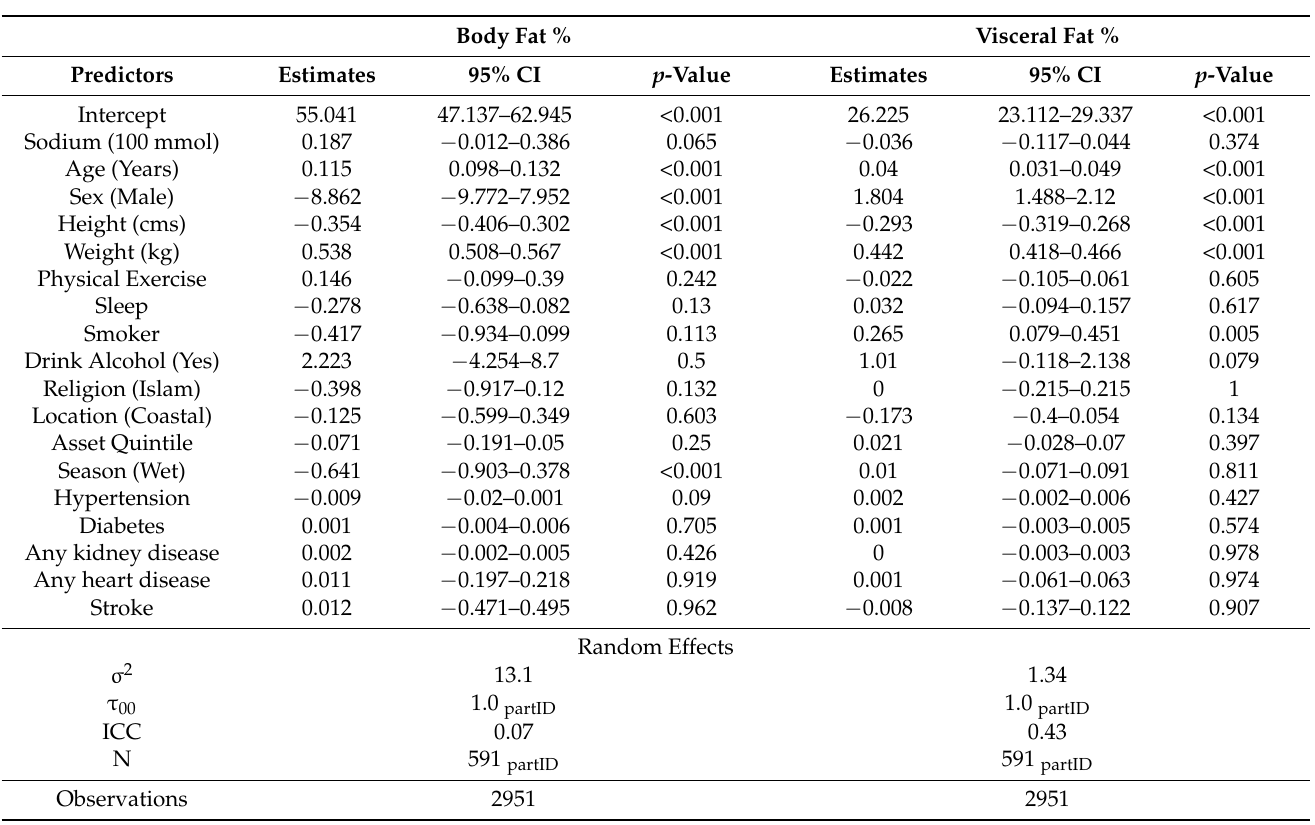
Table 9. Association between 24 h urinary sodium and 90th percentile body fat percentage and visceral fat percentage